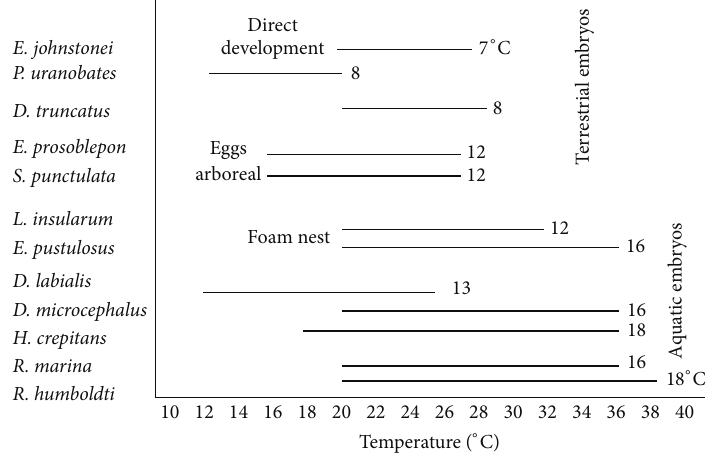
Figure 3: Range of thermal tolerances of the study species for an embryonic survival higher than